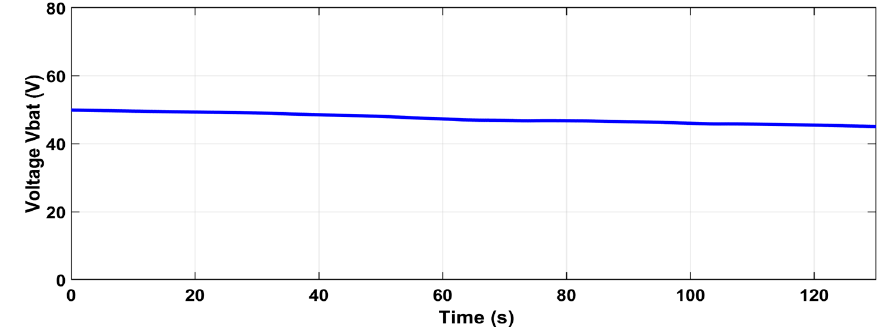
Figure 12. Supercapacitor current and reference.